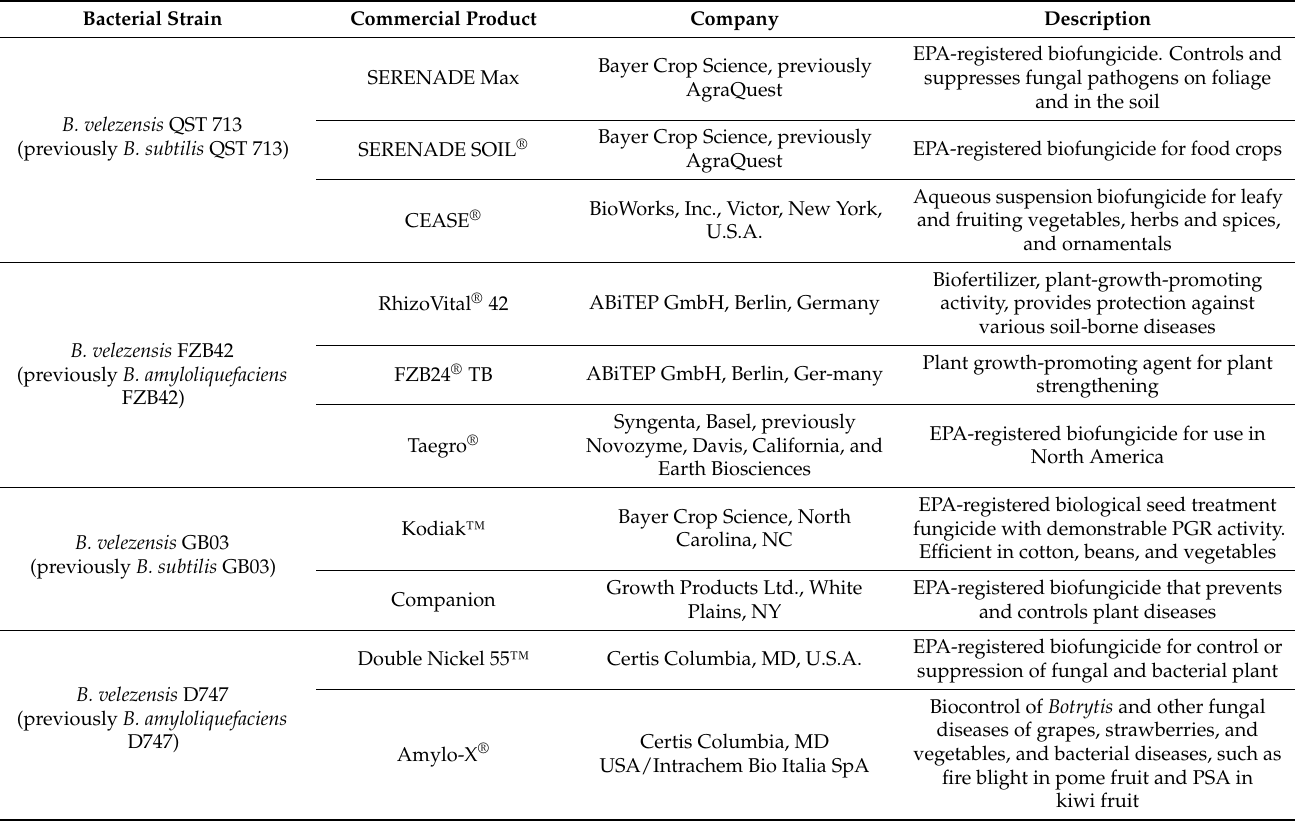
Table 3. Some commercial products containing the members of the operational group Bacillus amyloliquefaciens available on the